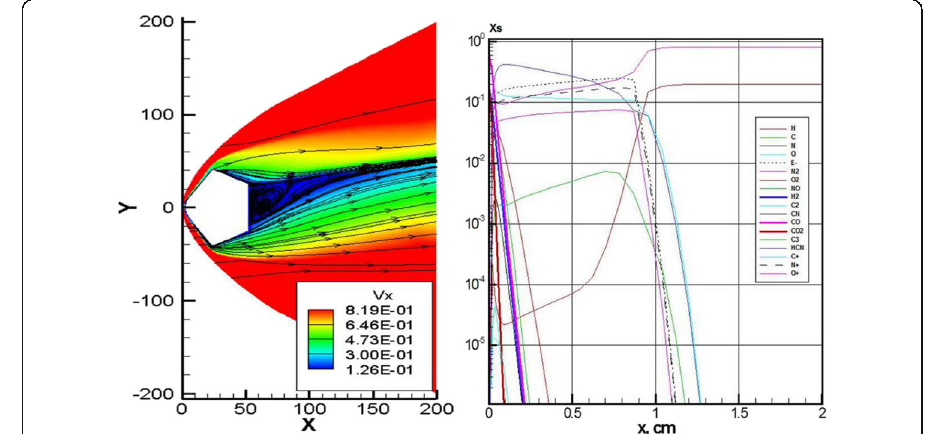
Fig. 19 Computational results of Stardust sample return